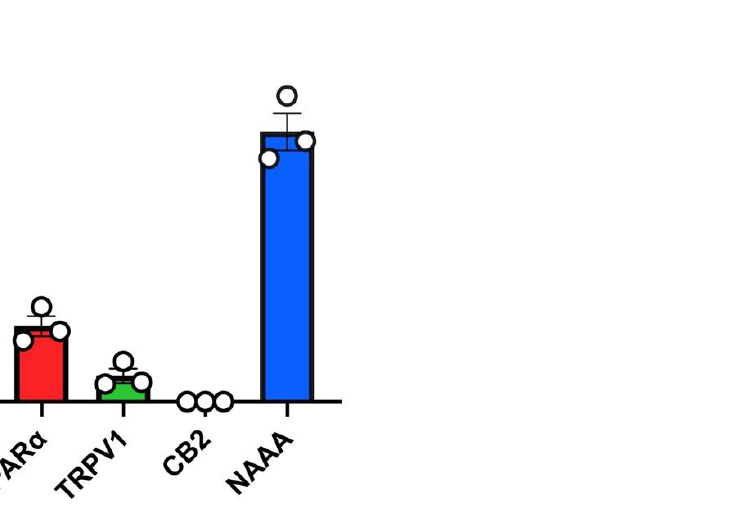
Figure 2. mRNA expression levels of PEA targets (PPAR α , TRPV1, CB2) and PEA-catabolizing enzyme (NAAA) in A549 cells. Bar chart with individual points showing the mRNA expression levels of the indicated proteins (PPAR α , TRPV1, CB2 and NAAA) measured in A549 cells. Each bar shows the mean ± SEM of 3 independent biological samples. Data are expressed using the 2 − ∆ ct formula.